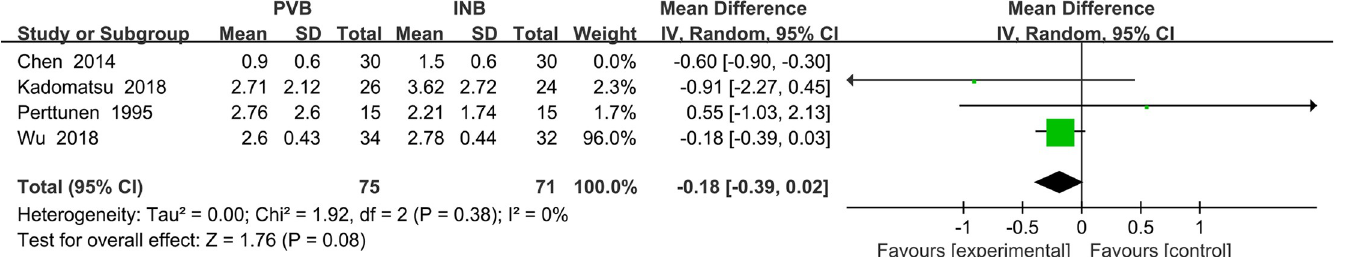
PLOS ONE | https://doi.org/10.1371/journal.pone.0237363 October 5,